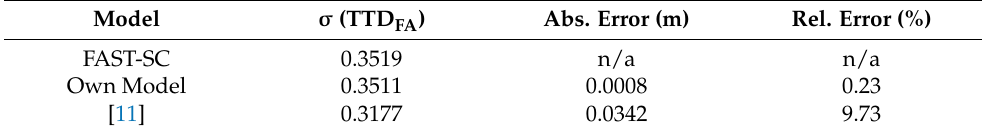
Table 6. Precision of the identified models.